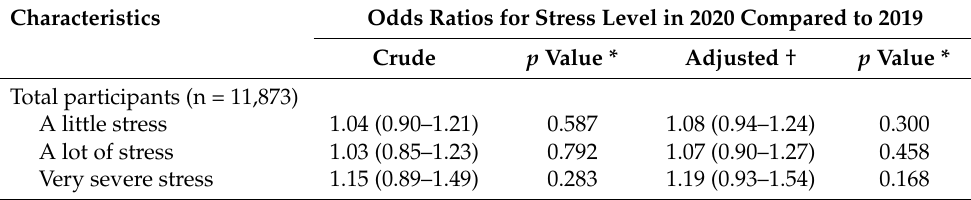
Table 3. Odds ratios (95% confidence intervals) for stress in 2020 compared to